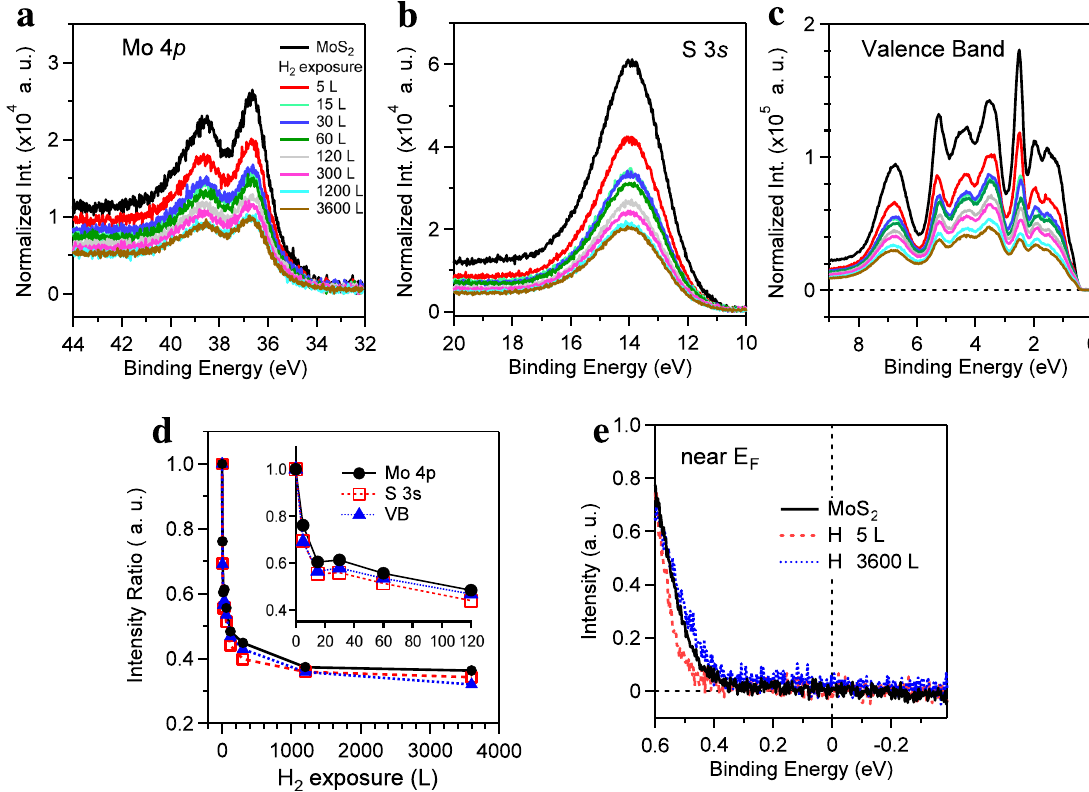
Figure 2. Reduction of the photoemission spectra by the hydrogen physisorption. Hydrogen gas adsorption on the cleaved MoS 2 surface in-situ at room temperature. Photoemission spectra of Mo 4p ( a ) and S 3 s ( b ) shallow core level, and valence band ( c ) were obtained at hv = 100 eV. ( d ) Plot of the relative intensity as a function of the H 2 exposure time. The inset shows a magnified region. ( c ) Valence-band maxima near the Fermi energy were obtained with high-resolution